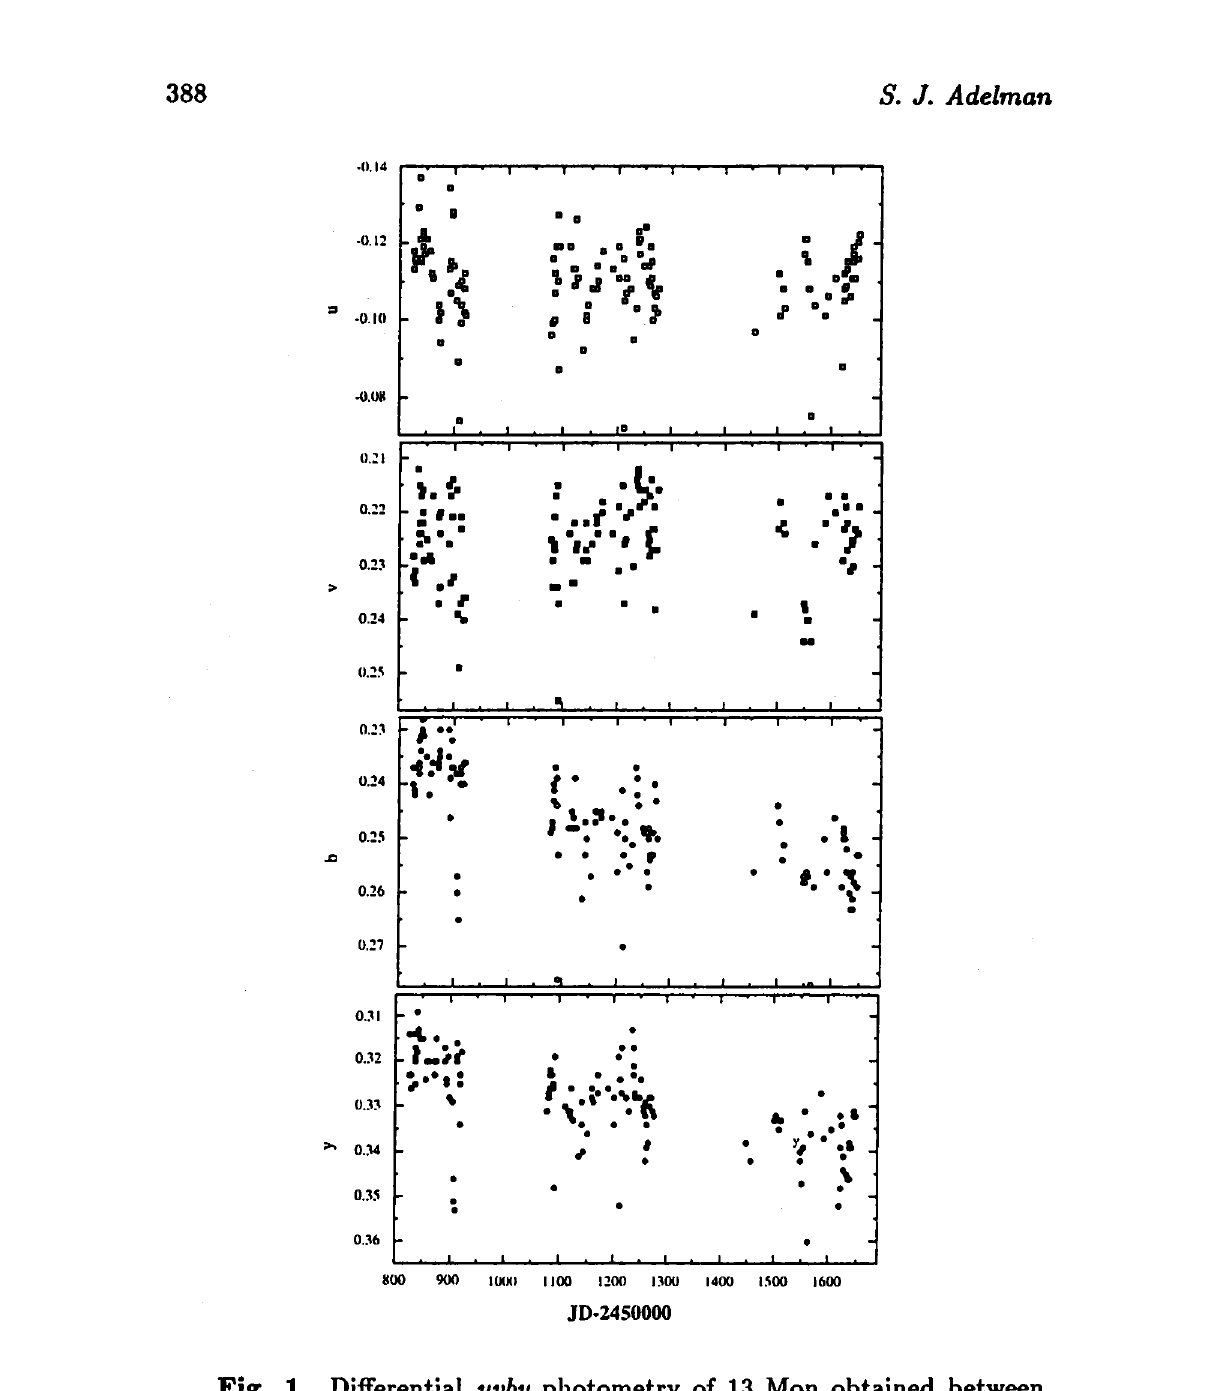
Fig. 1. Differential uvby photometry of 13 Mon obtained between 1996 and 2000. Open squares are u values, closed squares - v values, open circles - b values and closed circles - y